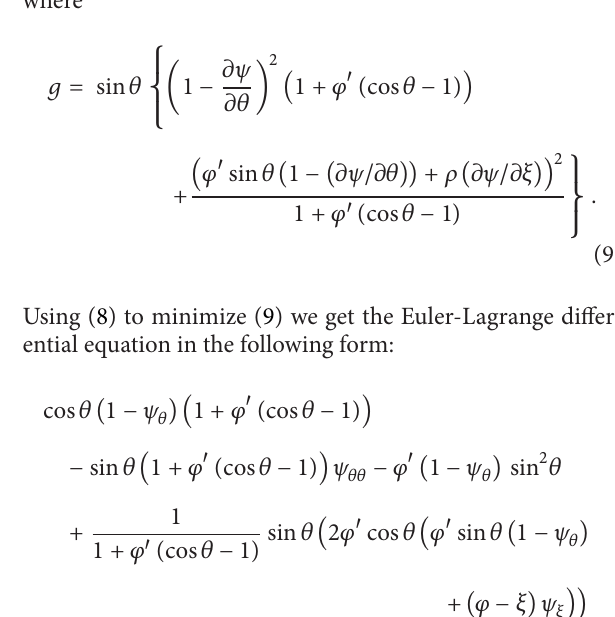
where 𝜑 󸀠 = 𝜕𝜑/𝜕𝜉 . The free energy is given